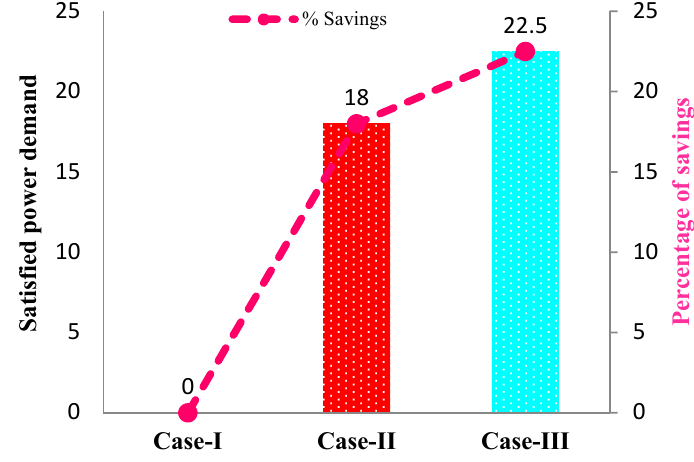
Figure 19. Percentage of satisfied power demand savings within cases I, II, and III over 24 h time horizon. Table 9. Comparison of the proposed and existing satisfied power demands within case-I, II and III. Cases Satisfied Power Demand % Saving Case I 0 0 Case II